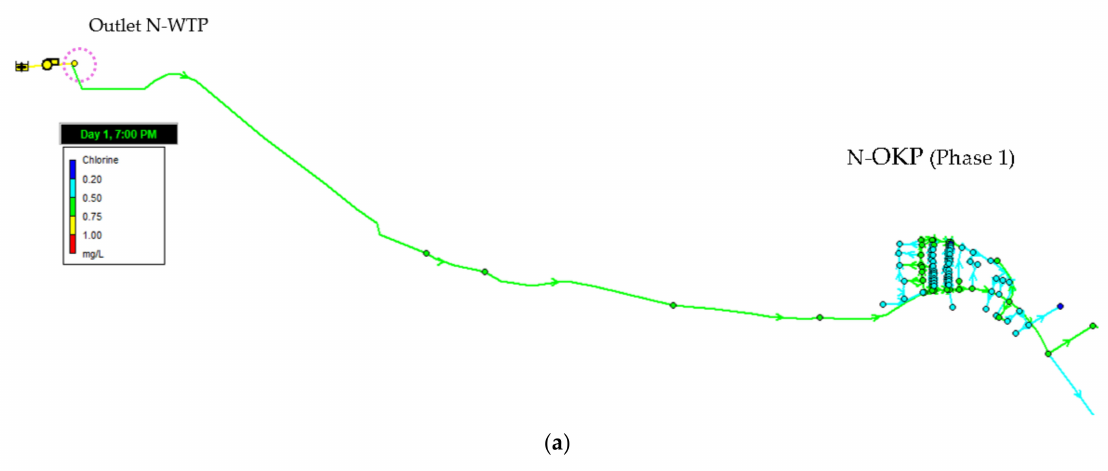
Figure 12. Simulation of chlorine in Phase 1 (N-WTP outlet: 1.8 mg/L): ( a ) network model, ( b ) residual chlorine in N-OKP, ( c ) time course of chlorine concentration, ( d ) observed vs. simulated chlorine.